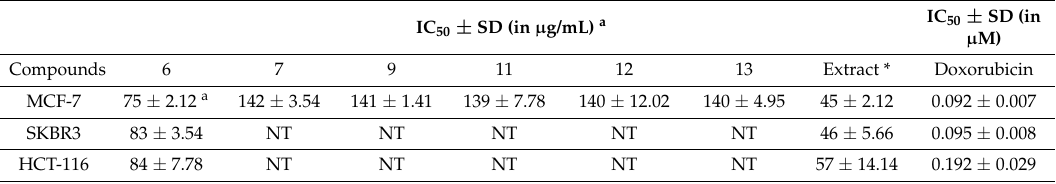
IC 50 ± SD (in µ M)